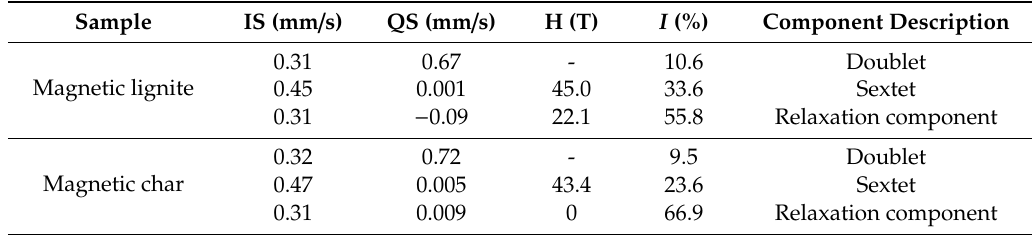
Table 3. Mössbauer parameters for the magnetic lignite and magnetic char. Mössbauer spectra are presented in Figure